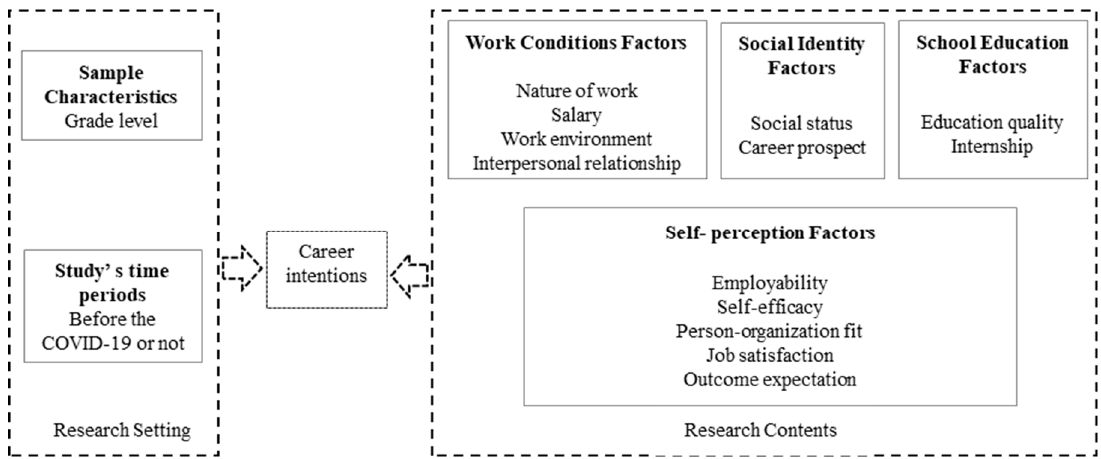
Figure 1. Proposed theoretical framework of career intentions and influencing